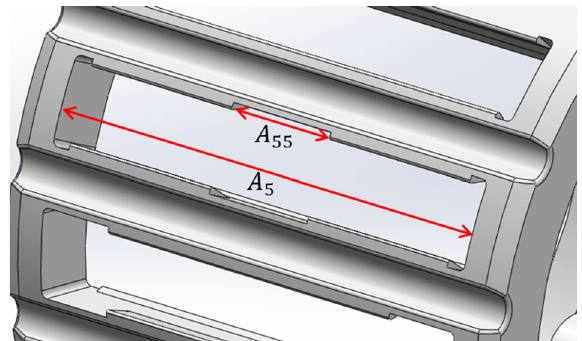
Figure 11. Pocket width and retention